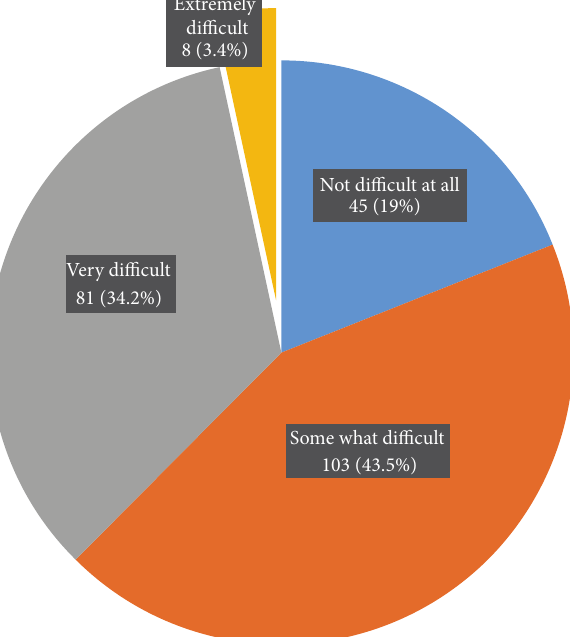
Figure 4: Level of difficulty of depressive symptoms among type 2 diabetic outpatients to do their work, take care of things at home, or get along with other people in Black Lion General Specialized Hospital, Addis Ababa, Ethiopia,